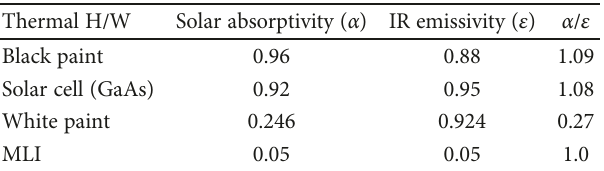
Table 4: Thermo-optical properties of thermal coatings used to shutter.